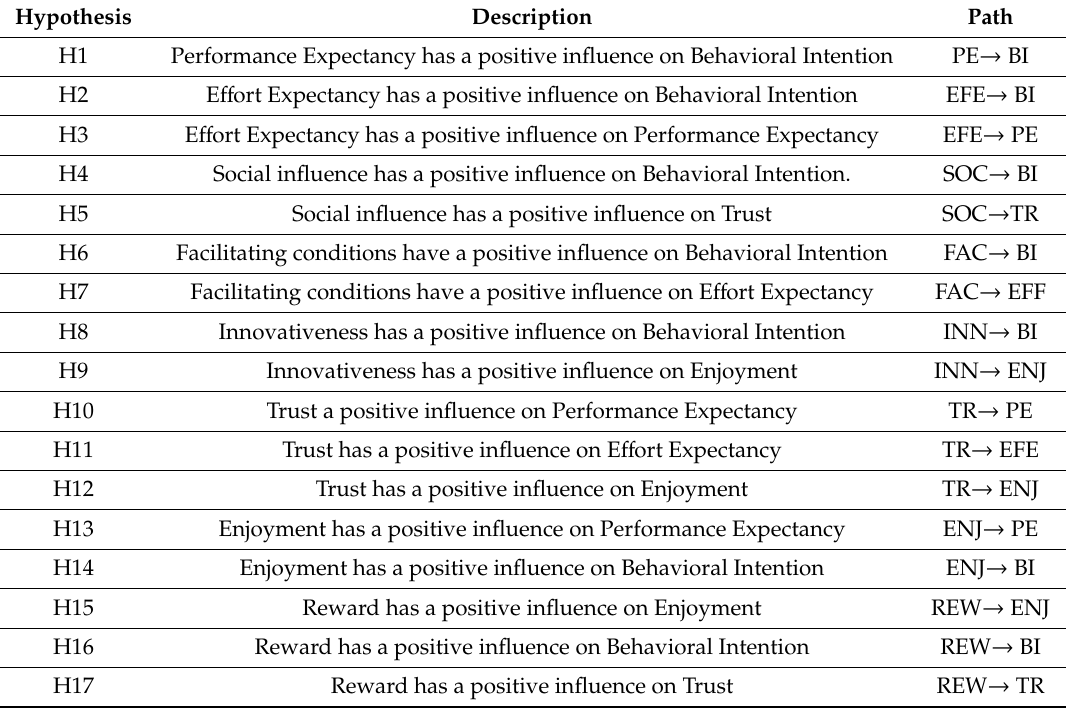
Table 1. Research